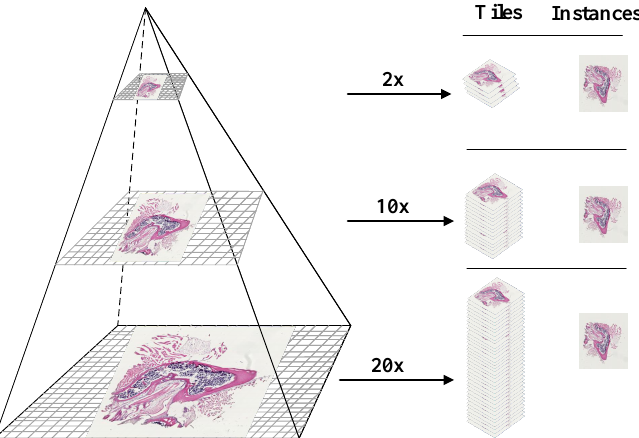
Figure 7. Mapping a DICOM-compliant multi-resolution WSI pyramidal image. Each layer of the pyramid is a downsample of the WSI picture and is made up of a series of tiles. The tiles are encrypted as separate frames of the multi-frame DICOM instances